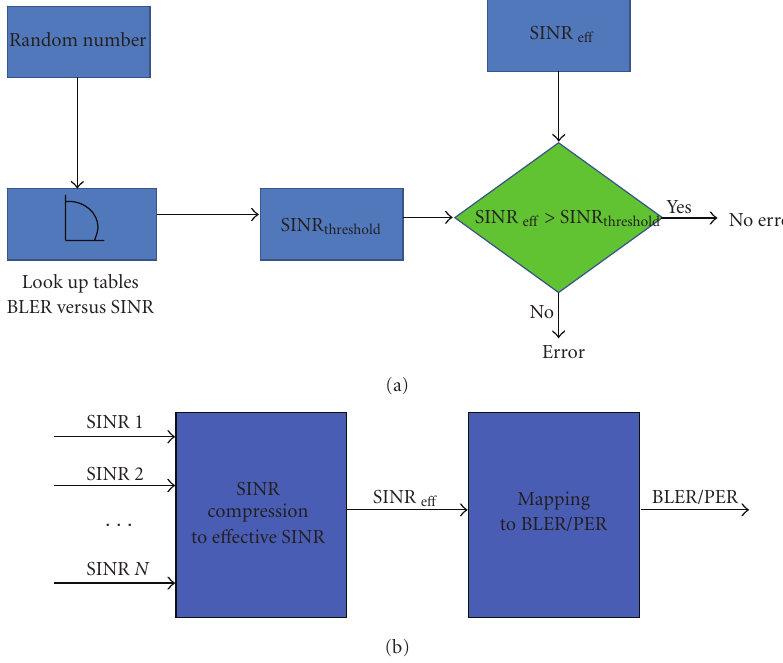
Figure 6: (a) ARQ acceptance process. (b) E ff ective SINR